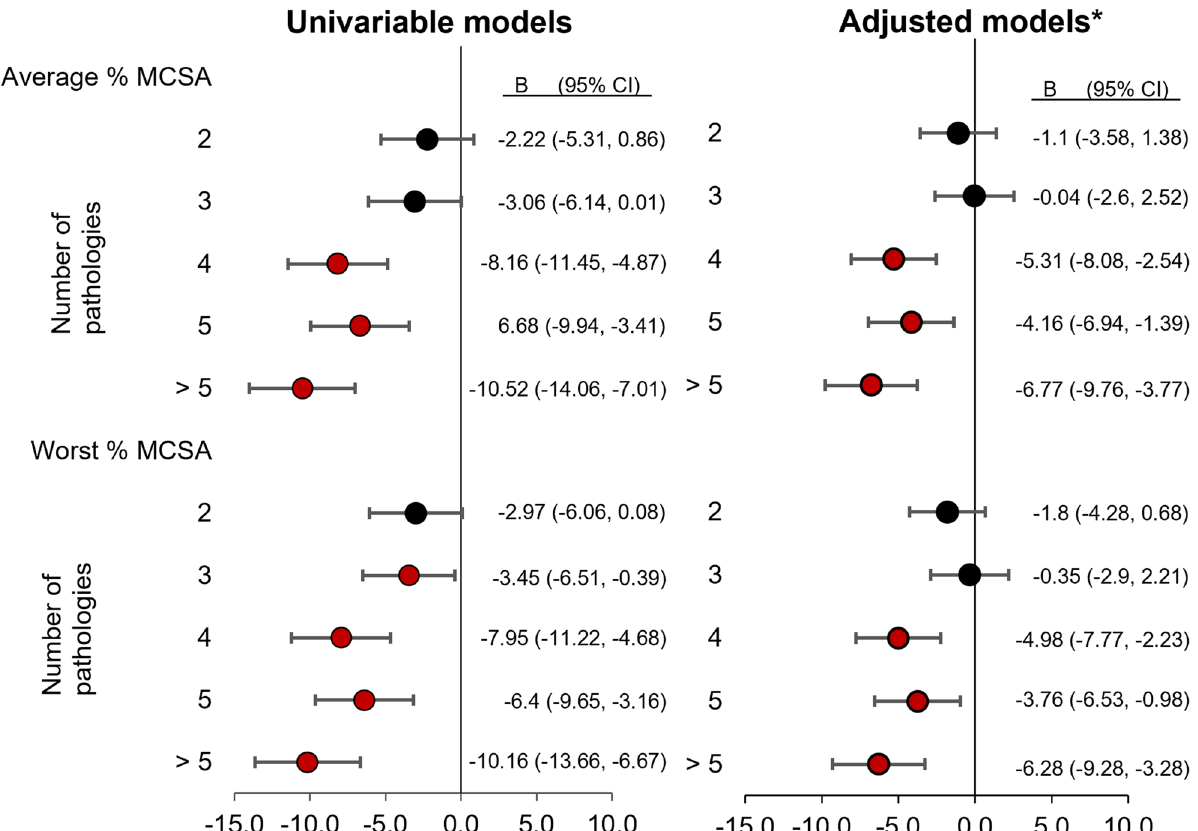
Figure 4. Linear regression [combined pathologies]. *Adjusted for age, sex, and BMI. % MCSA = proportion of peak muscle cross-sectional area; B = unstandardized beta coefficient; CI = confidence interval. NB: for each model, the reference category is < 2 pathologies